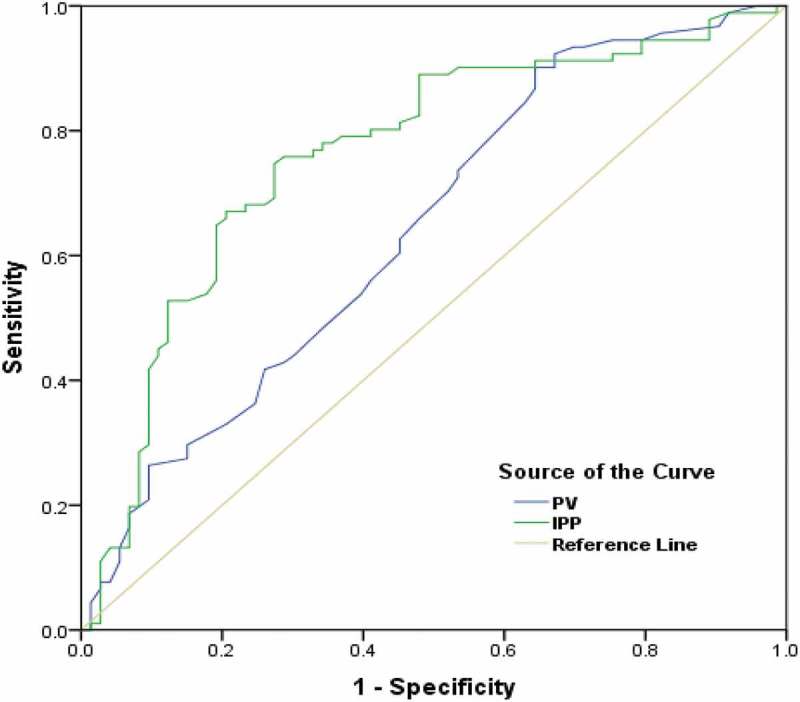
ROC curves of IPP and PV for BOO.